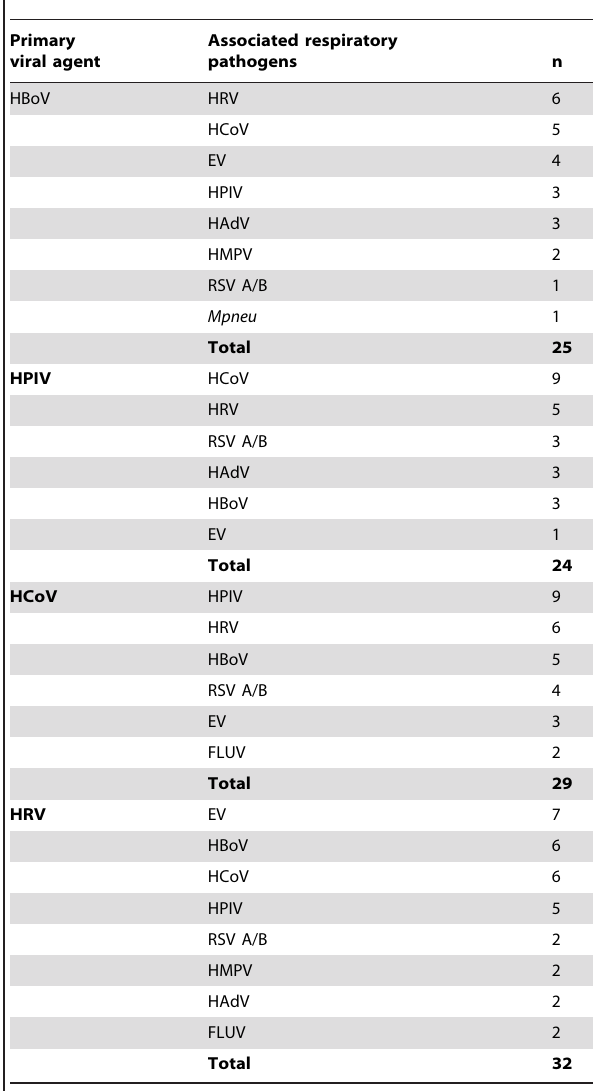
Total represents the number of co-detected pathogens from each primary viral